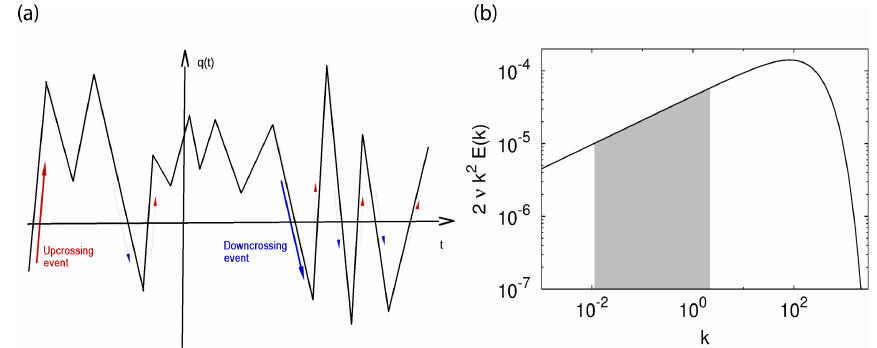
Figure 1. (a) A signal q(t) crossing the level q = 0. (b) Dissipation spectra: the range of k numbers covered by the POST measurements is denoted by the color